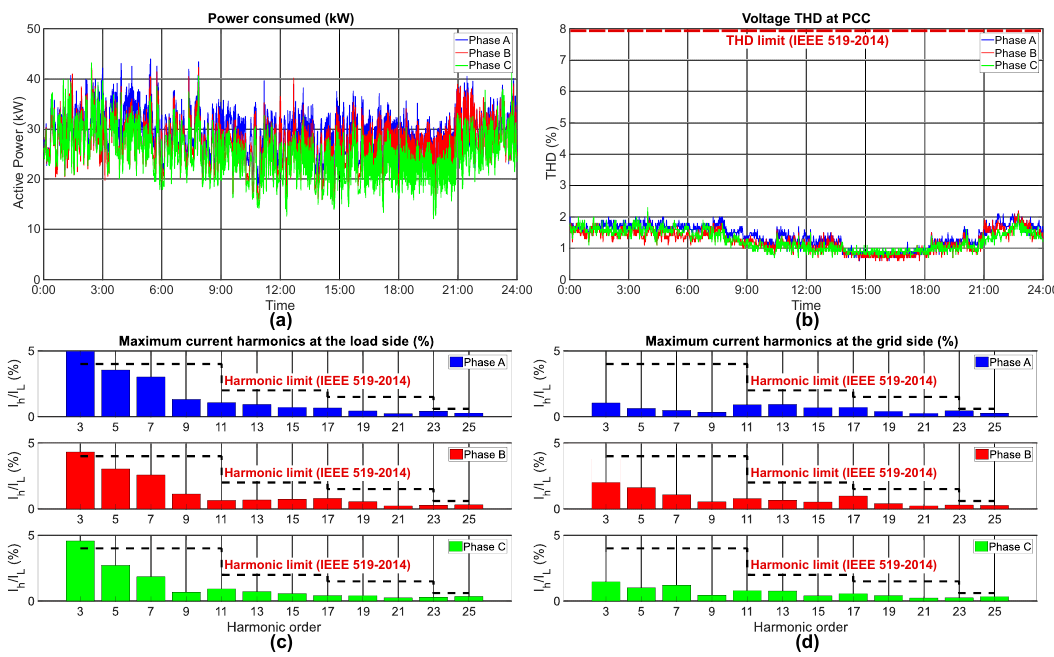
Figure 12. Measurements at the factory: ( a ) active power; ( b ) voltage THD; ( c ) maximum current harmonics consumed by the loads; ( d ) maximum current harmonics at the grid side.